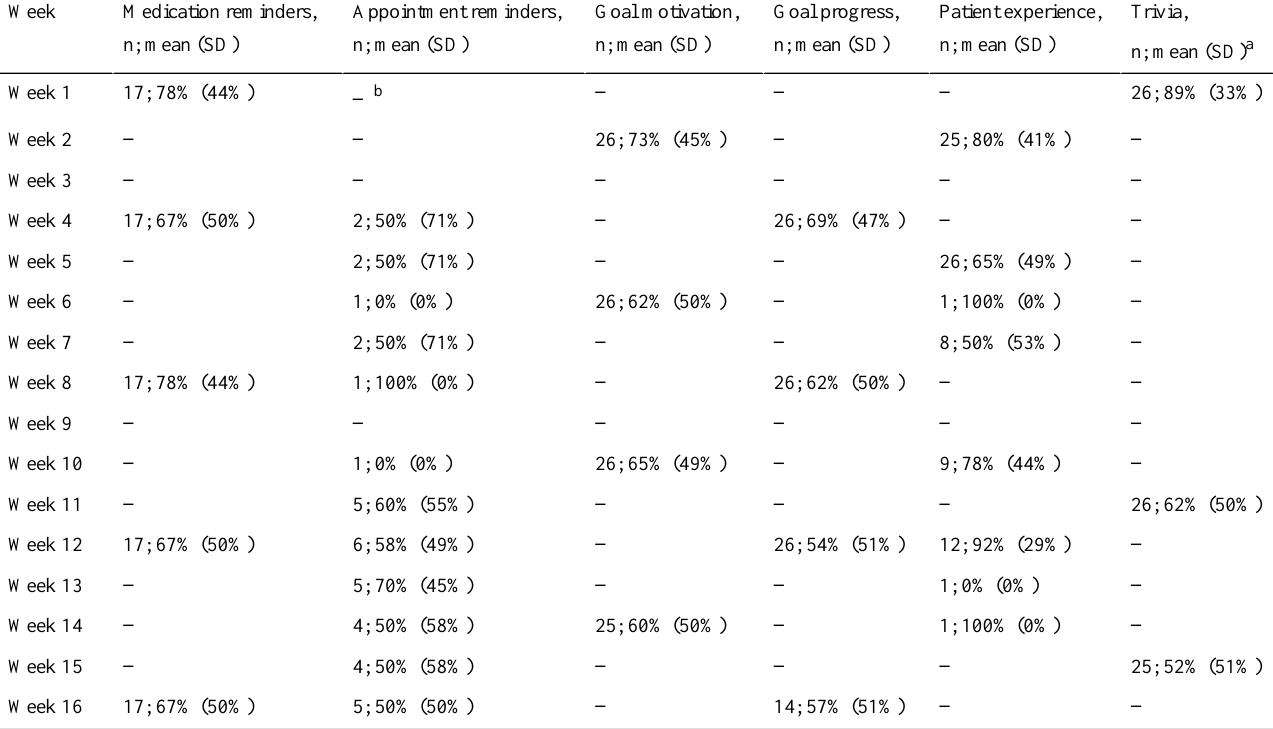
Table 4. Means and SDs for text message responsivity (%) across categories of text messages received intermittently during the